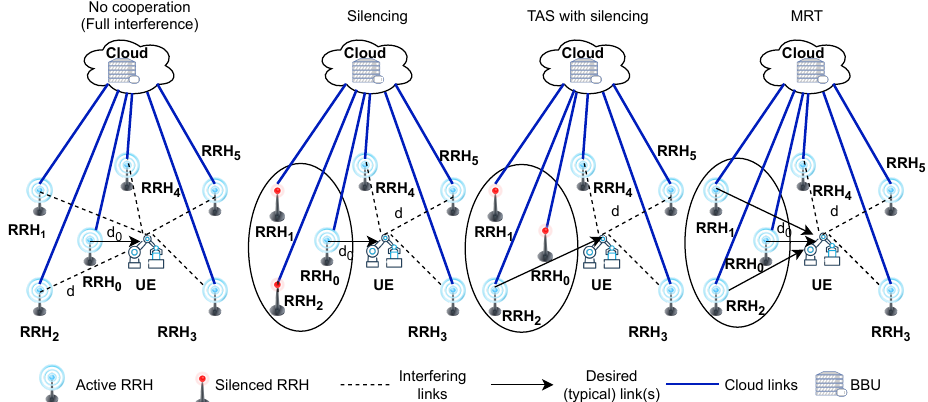
Figure 1. Illustration of the CRAN system model for different transmission schemes with a typical link and N = 5 interfering